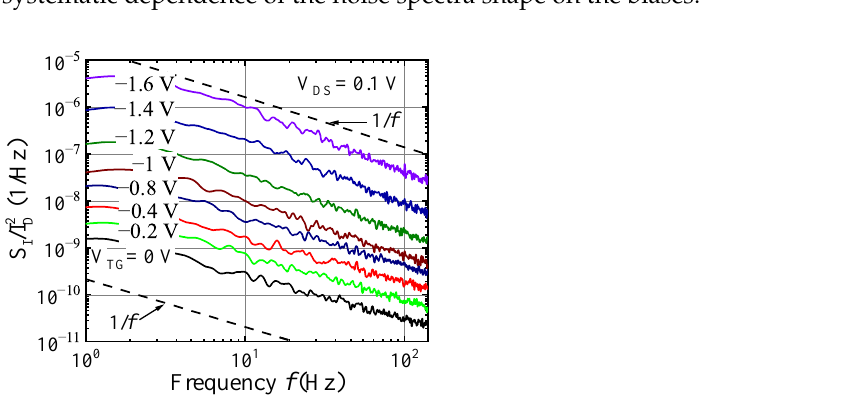
Figure 6. Noise spectra S I / I 2 for one of the FinHEMTs at drain V D = 0.1 V, back gate voltage D V BG = 0 V and different top gate voltages V TG